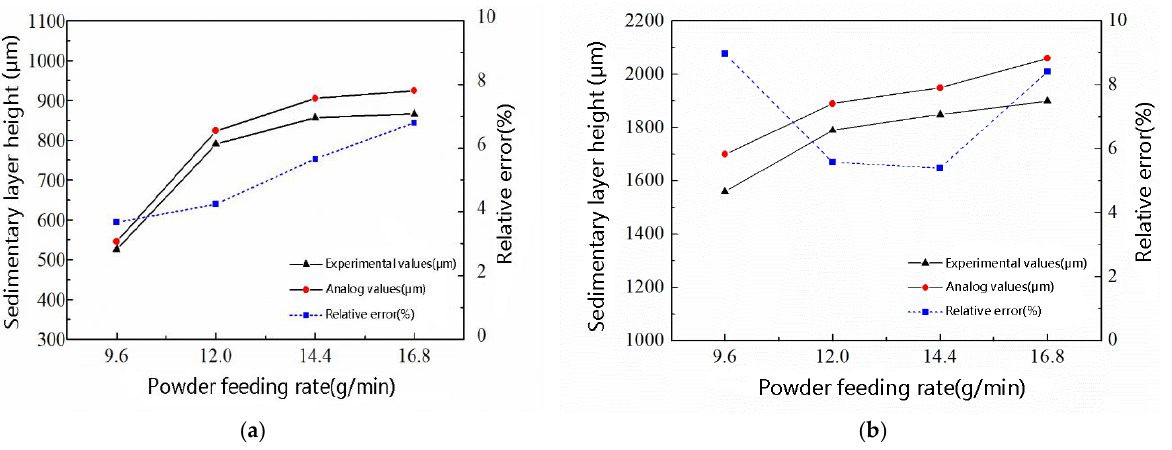
Figure 6. Deposition channel size at different powder feeding rates. ( a ) Variation of sedimentary channel height with scanning speed; ( b ) Variation of sedimentary channel width with scanning speed.